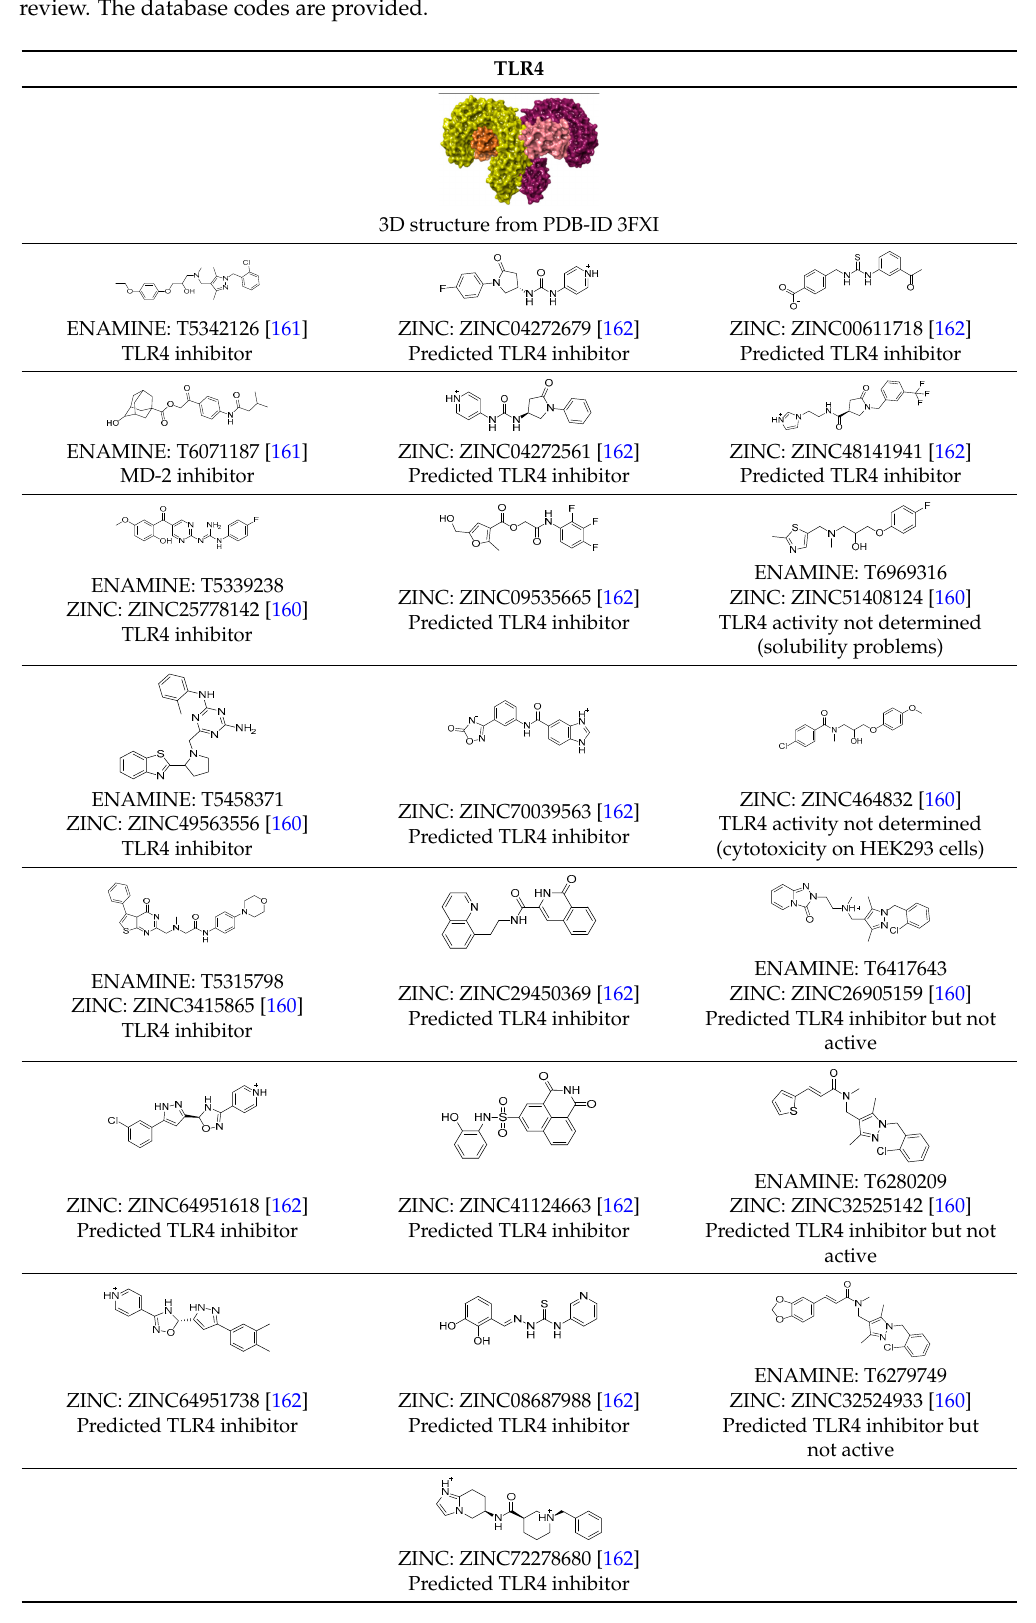
Table 4. 2D Chemical structure of TLR4 modulators identified by VS techniques and mentioned in this review. The database codes are provided.